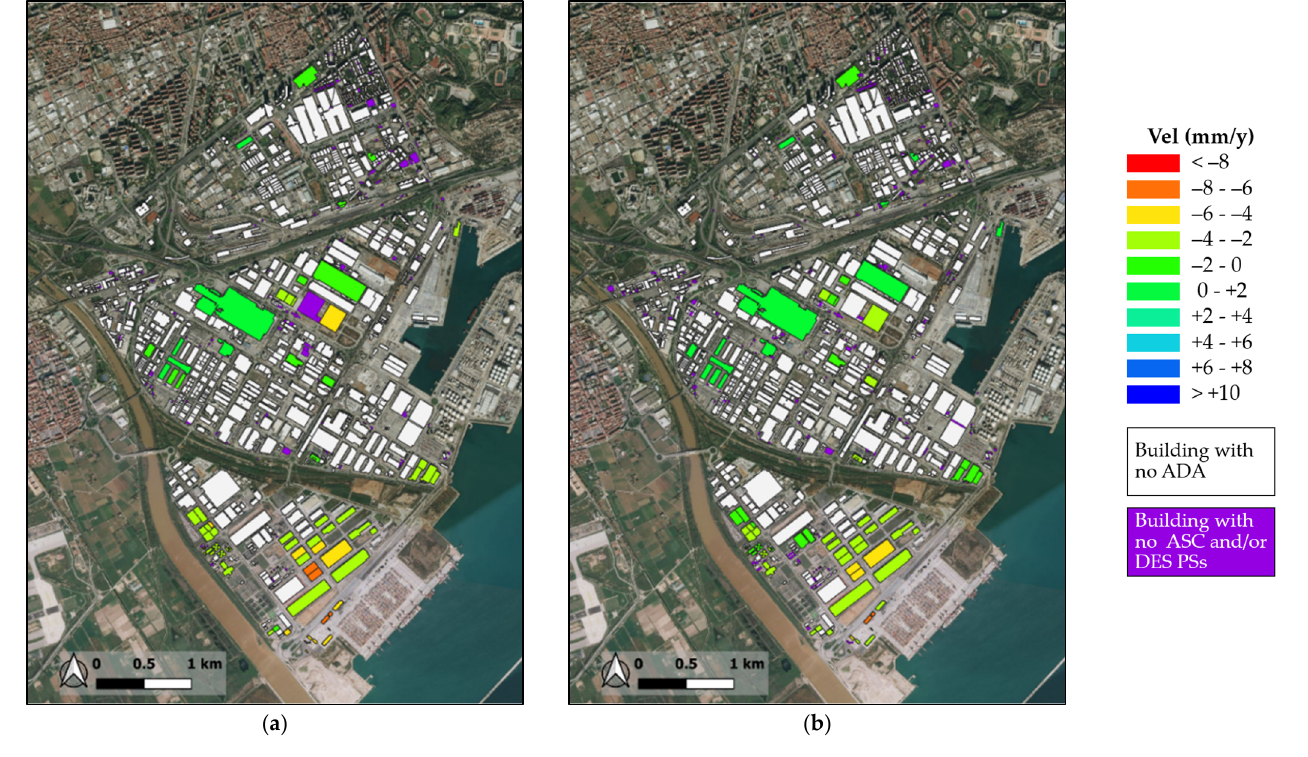
Figure 6. Maps of buildings in Eixample area with an average value of mean deformation velocity along